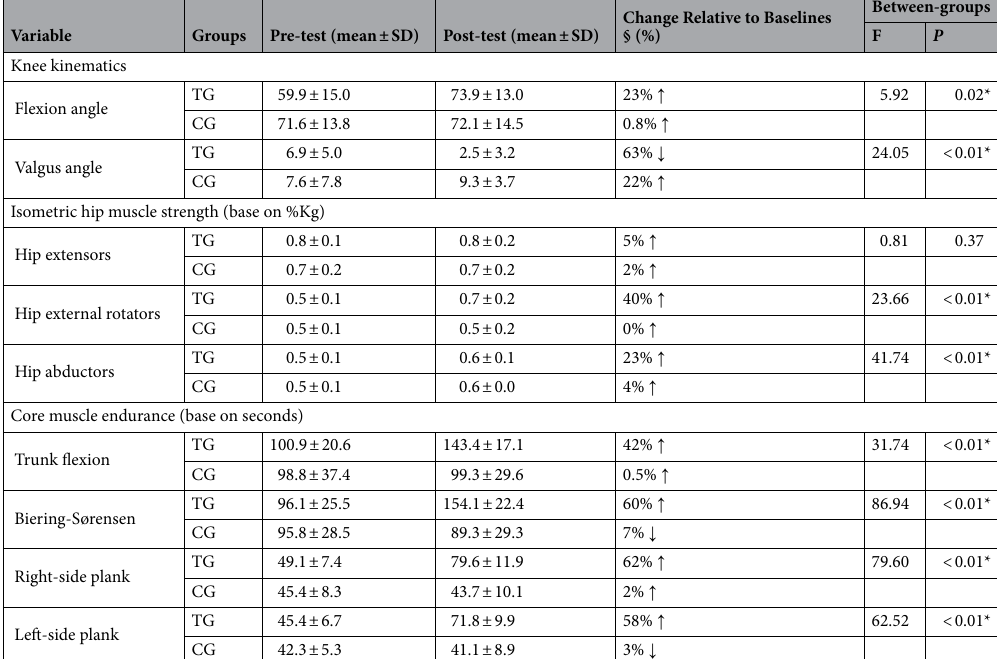
Table 2. Effect of training on variables. TG = Training Group; CG = Control Group. § , Percent change ( ↓ decrease, ↑ increase). *, Significant.